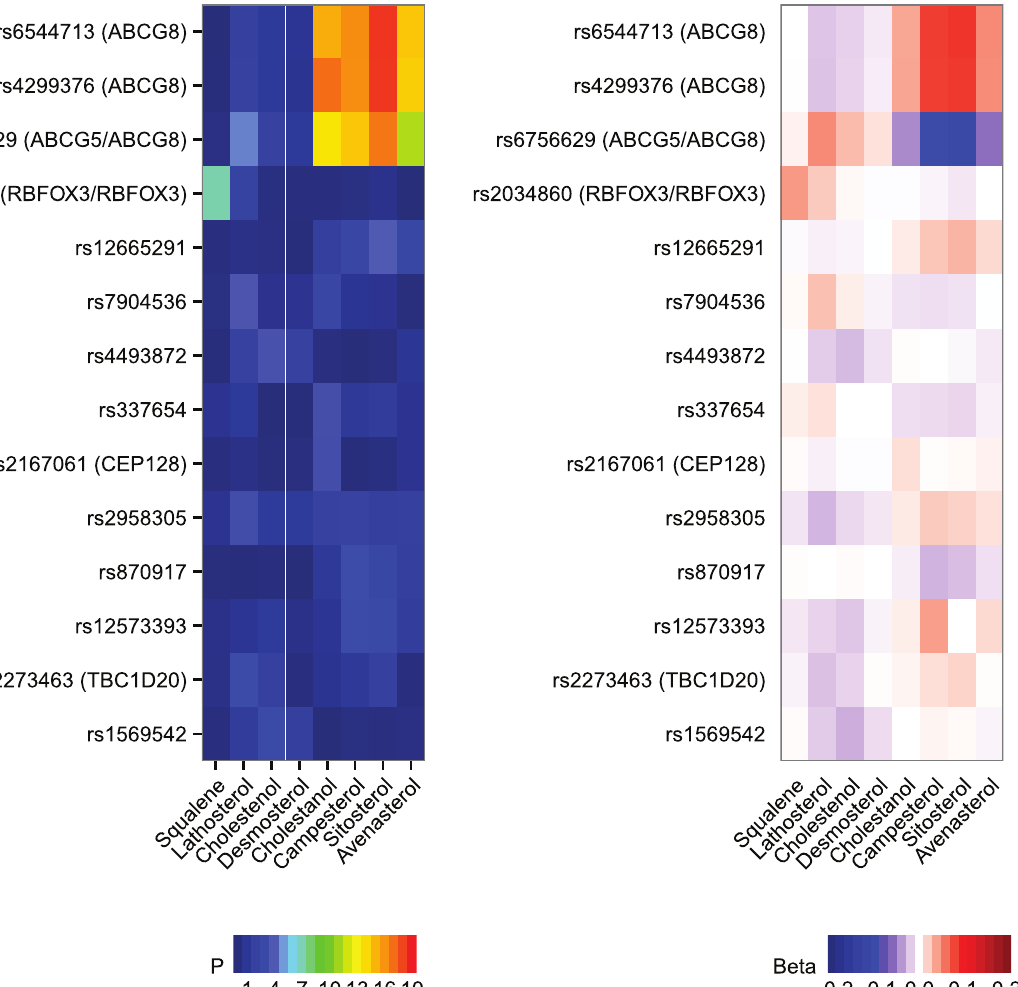
Figure 2. SNPs associated with sterol levels (left panel) and the effect size evaluated by the standardized b coefficient from linear regression model (right panel). Genotyping results represent a meta-analysis of 1 st stage (GWAS, EUGENE2 Study) and 2 nd stage of targeted replication (METSIM Study), total N=1,013. SNPs having an association P , 0.001 are shown. Individuals with previously diagnosed diabetes and on statin or ezetimibe treatment were excluded. P -values are adjusted for age, gender and